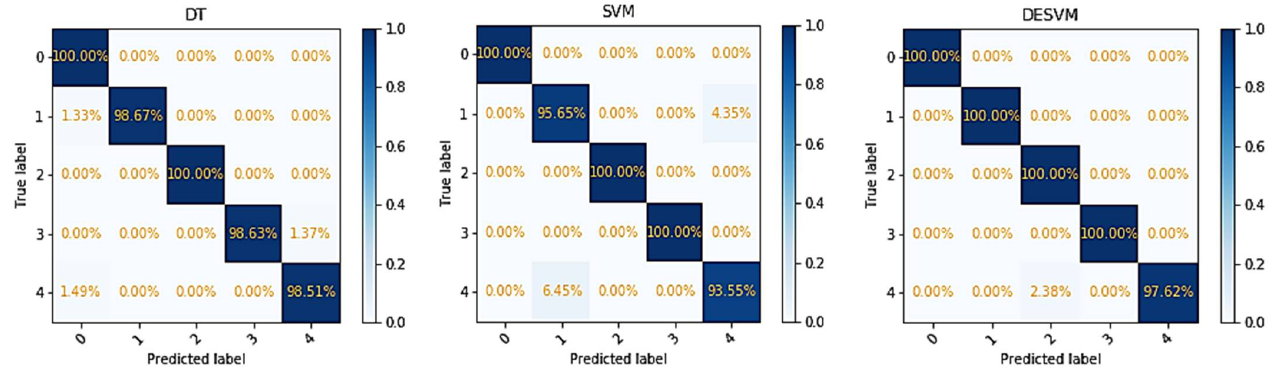
Figure 9. The confusion matrix of the recognition results for GNB, DT, KNN, RF, SVM, and DESVM machine learning algorithm.